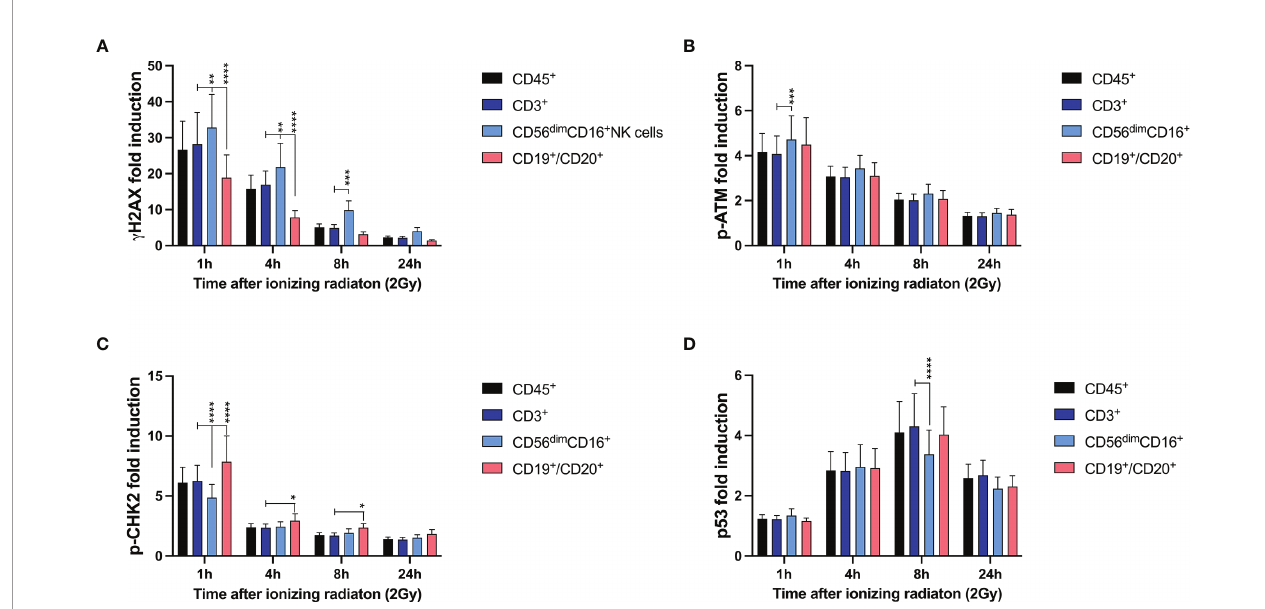
FIGURE 1 | DNA damage response to ionizing radiation differs among T, B, and NK lymphocytes. Peripheral blood mononuclear cells (PBMCs) from 26 healthy donors were irradiated with 2Gy and fi xed at indicated time points. Surface markers of lymphocyte subsets and intranuclear DDR biomarkers were analyzed by mass cytometry. Induction of g H2AX (A) , p-ATM (B) , p-CHK2 (C) , and p53 (D) were calculated in CD45 + lymphocytes, CD45 + CD3 + T cells, CD45 + CD56 dim CD16 + NK cells and CD45 + CD19 + CD20 + B cells based on mean fl uorescence intensities normalized on unirradiated samples. Bars represent mean values; error bars represent standard deviations. Signi fi cance is shown for NK and B lymphocytes in comparison to T cells (*p ≤ 0.05, **p ≤ 0.01, ***p ≤ 0.001, ****p ≤